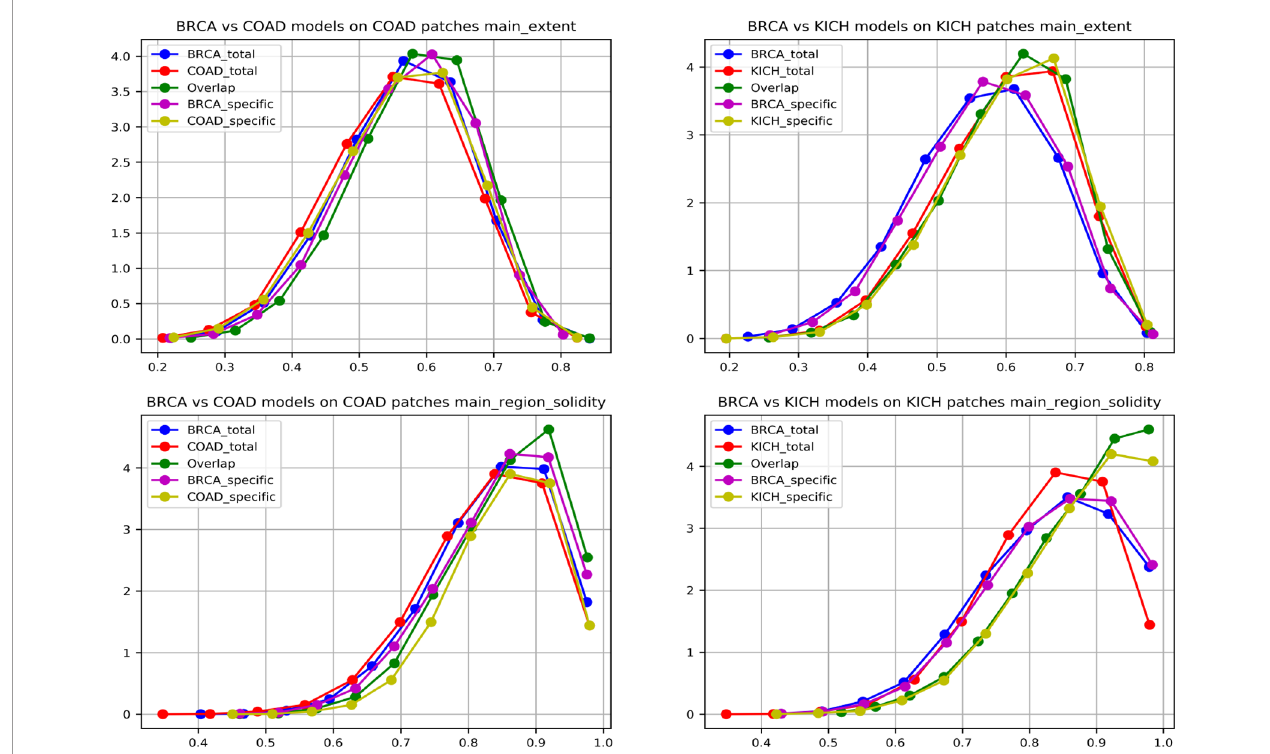
FIGURE 9 | Graph showing nuclei shape distribution of BRCA and COAD models inferred on COAD patches (left) and BRCA and KICH models inferred on KICH patches (right). The x-axis represents value of the feature, and the y-axis represents the PDF. In each subplot, “ Total ” is the overall high-attention region of the corresponding model, “ overlap ” is the common region of high attention for the two models, and “ speci fi c ” is the “ total ” region excluding the “ overlap ”